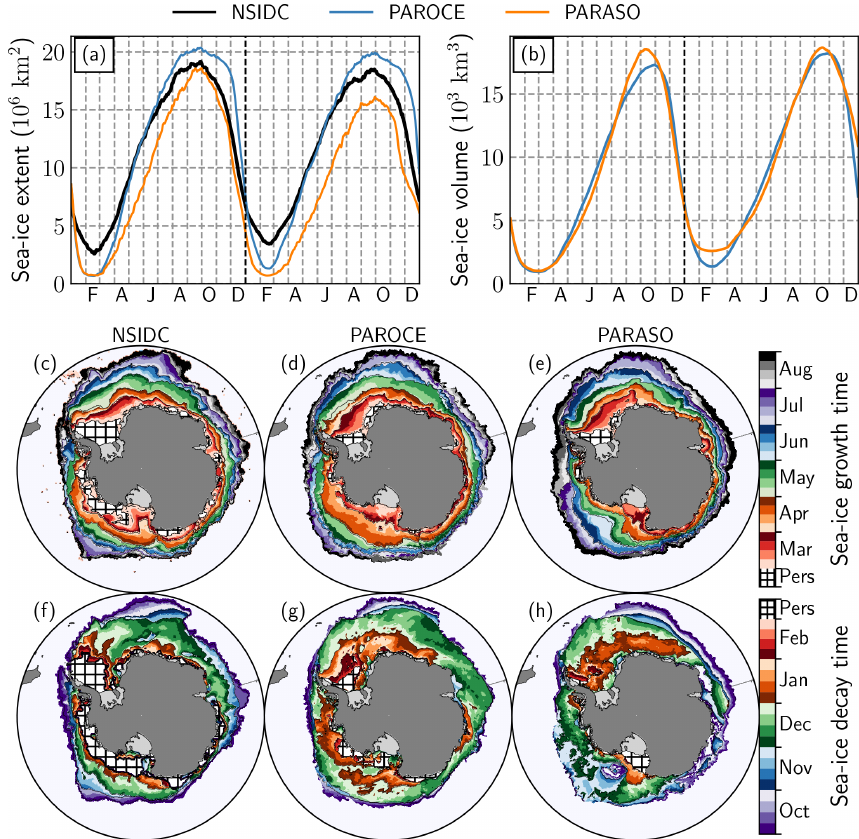
Figure 8. (a) Daily sea-ice extent from observations (NSIDC-G02315), PAROCE and PARASO, over 2000–2001. (b) Same for sea-ice volume (no observations available). (c–e) Sea-ice growth progression over the 2000 freezing season from (c) observations (NSIDC-0051), (d) PAROCE and (e) PARASO. The shadings indicate the earliest time of the year at which sea ice appears after the yearly minimum (in February 2000). (f–h) Same for the sea-ice decay progression over the 2000–2001 melting season. The shadings indicate the earliest time of the year at which sea ice disappears after the yearly maximum (early September 2000). On both color bars, “pers” indicates persisting sea ice throughout each full freezing or melting process. Sea-ice presence is defined by a 15% concentration threshold.